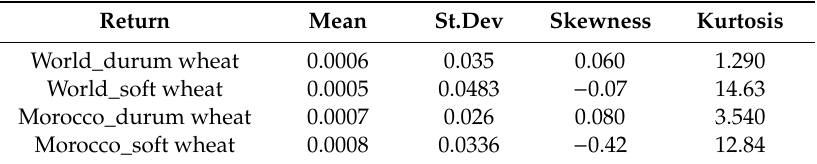
Table 1. Descriptive